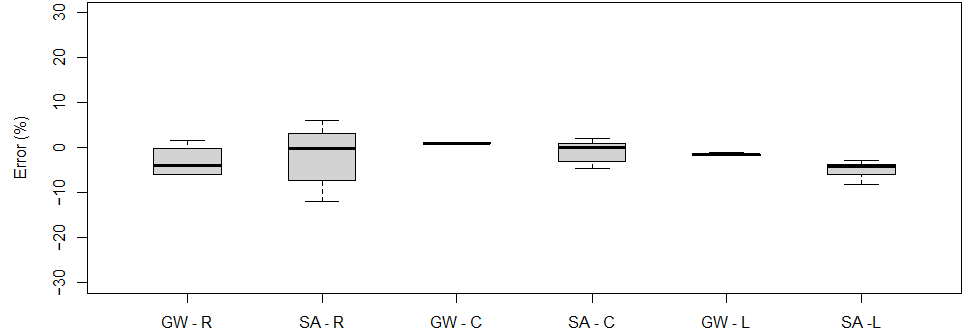
Figure 13. Measurement errors obtained for gross weight (GW), single axle (SA) for a five-axle vehicle: R—right-side run, C—central run, L—left-side run (the top and bottom of each box represent the 75th and 25th percentile values, whiskers show the minimum and maximum, the horizontal line represents median).